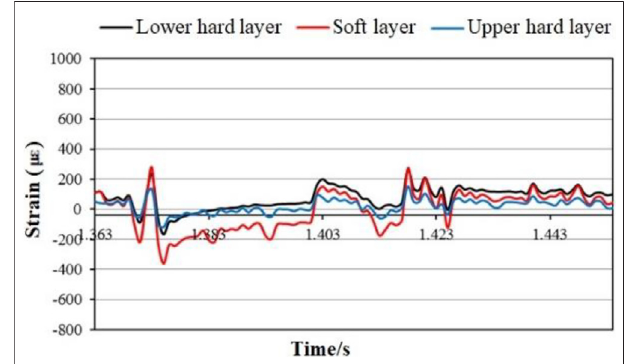
FIGURE 7 | Radial strain characteristic curve Ⅱ of each layer during simultaneous blasting of Nos 1, 2, and 3.